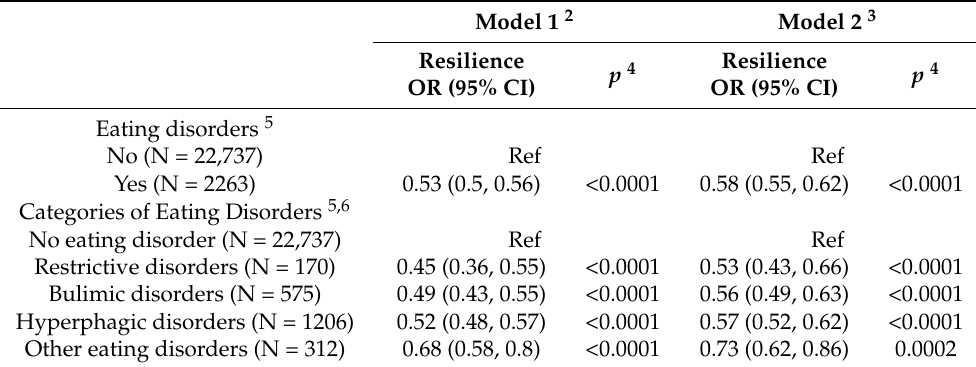
Table 2. Cross-sectional associations between resilience (BRS) (independent variable) and eating disorders (EDs) (SCOFF questionnaire) (dependent variable) in 2017 1 .